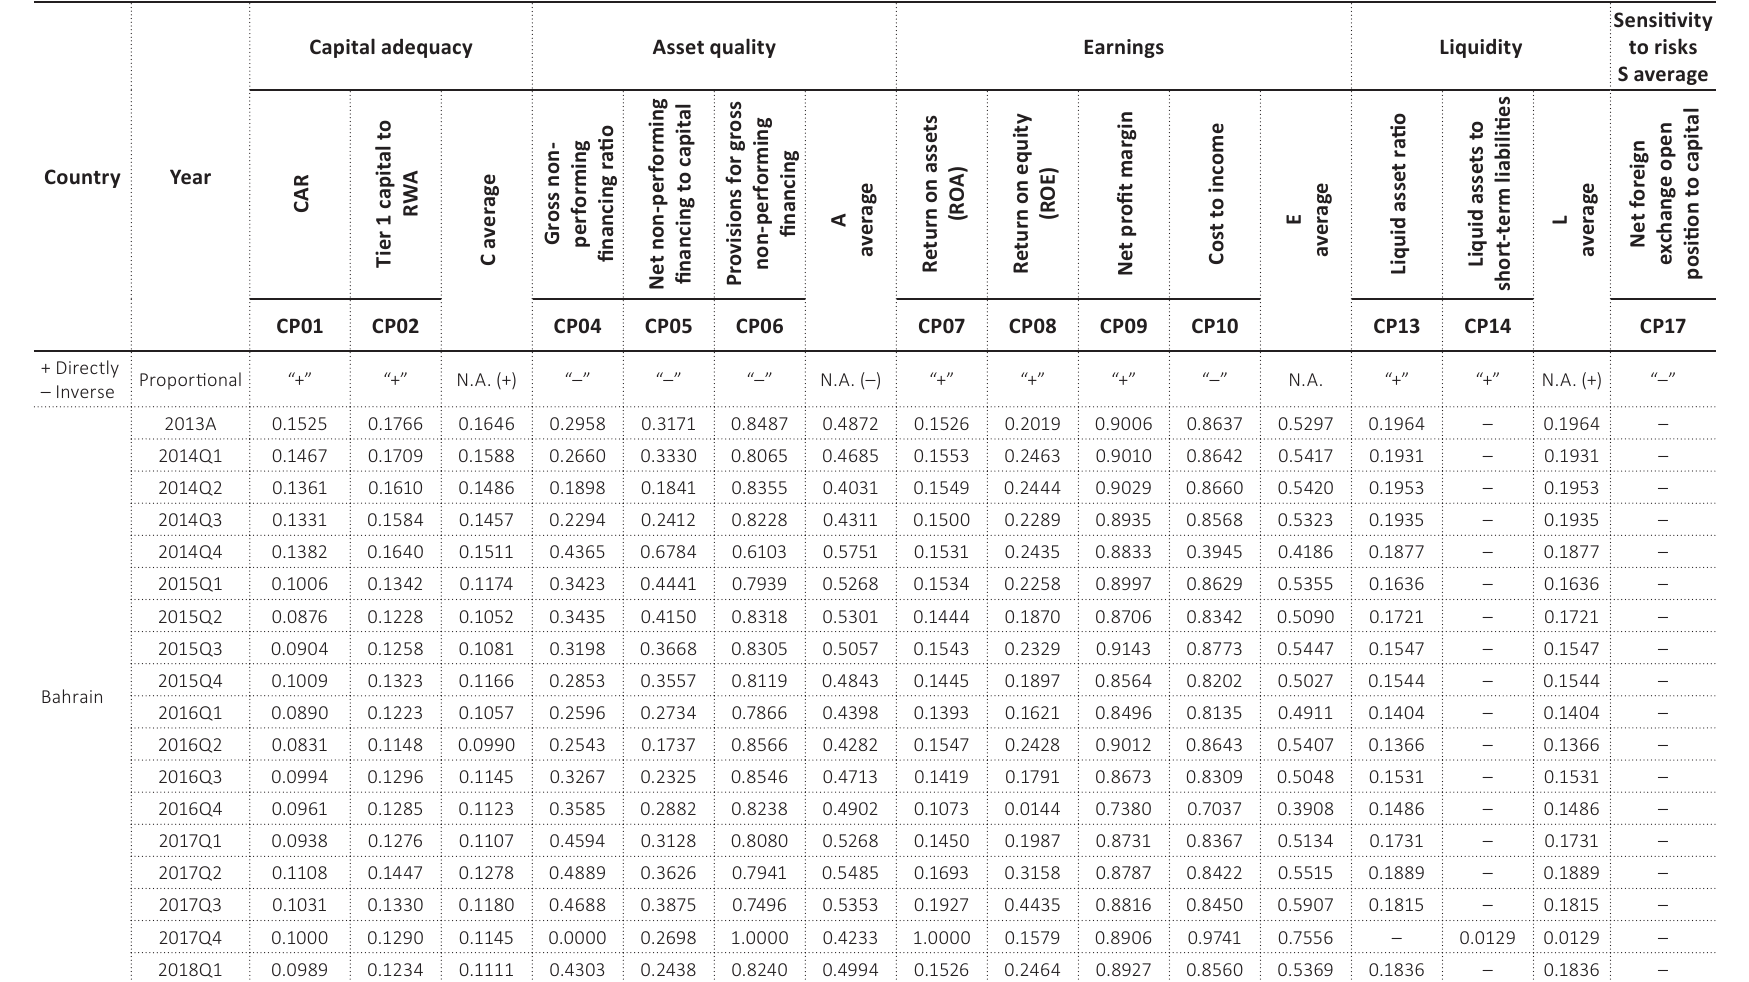
Table A1. Standard CAELS data of